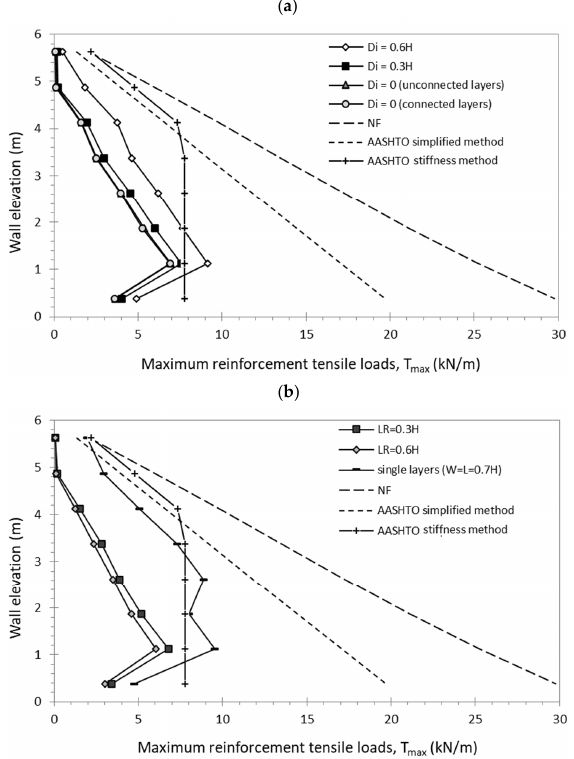
Figure 17. Numerical maximum tensile load for walls with different interaction distances ( D i ) between the back of the reinforced soil zones for opposite walls: ( a ) D i > 0 and D i = 0, and ( b ) D i < 0, and both cases compared with maximum tensile loads computed using AASHTO (×2) and NF design codes.